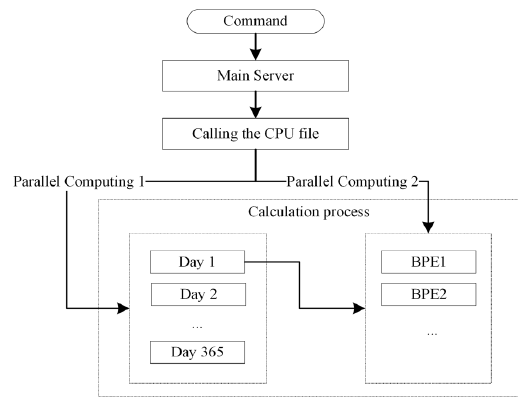
Figure 3. Flowchart of parallel computing.